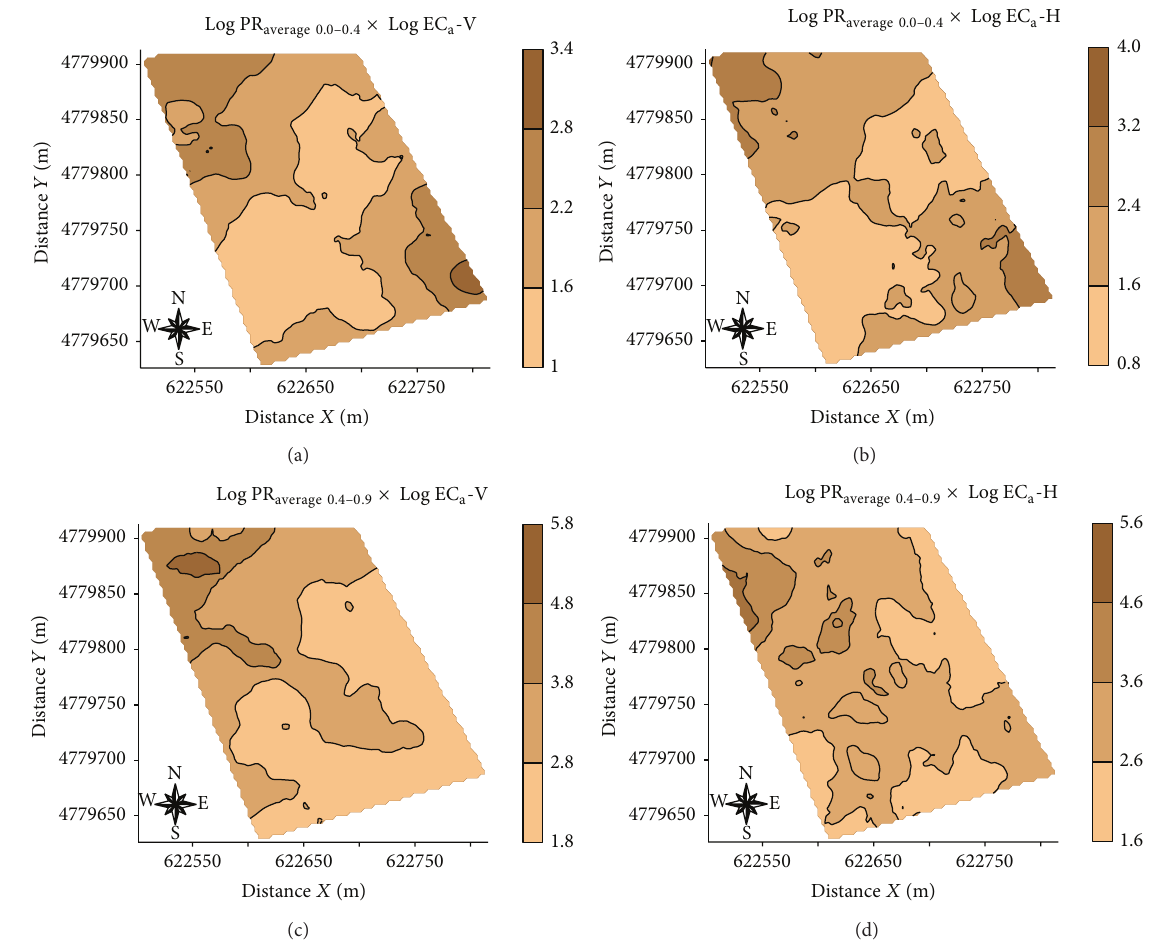
Figure 7: Maps of soil resistance to penetration at the layers 0.0–0.4 m (PR -V and EC -H as secondary cokriging using EC a a